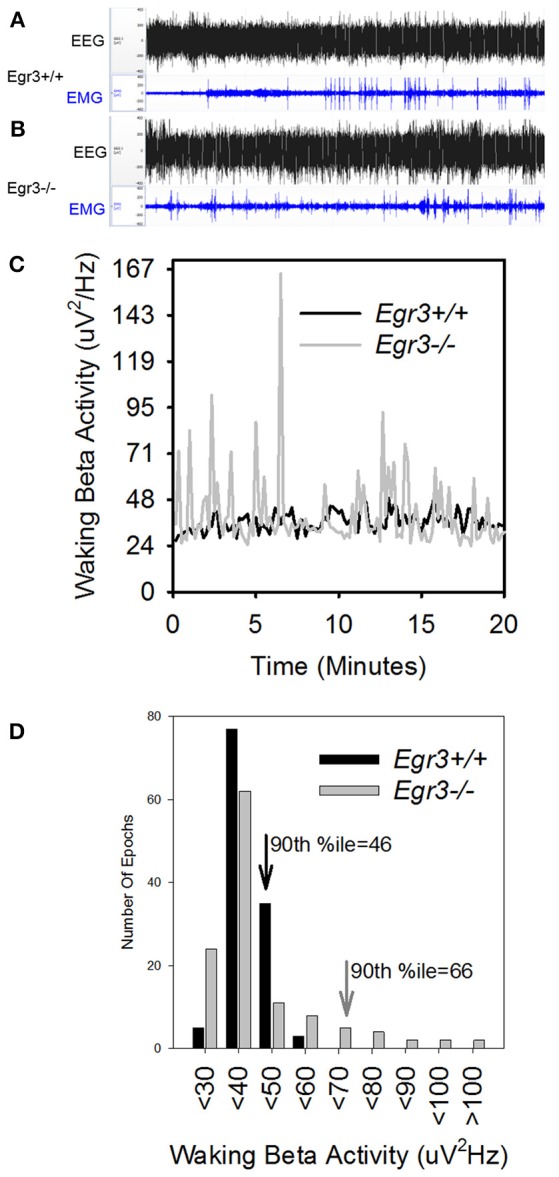
EEG state instability in Egr3−/− mice. (A,B) EEG (black) and EMG (blue) traces from an Egr3+/+
(A) and an Egr3−/−
(B) mouse, collected during a 20-min interval of wakefulness. (C) EEG spectral power in the beta (15–35 Hz) range from a representative Egr3+/+ (black) and an Egr3−/− (gray) mouse during a 20-min interval of wakefulness, plotted in 10 s intervals. (D) Data from (C) plotted as histograms. The 90th percentile value for spectral power in the beta (15–35 Hz) range from the Egr3+/+ animal is indicated by a downward pointing black arrow and that of the Egr3−/− by a gray arrow.